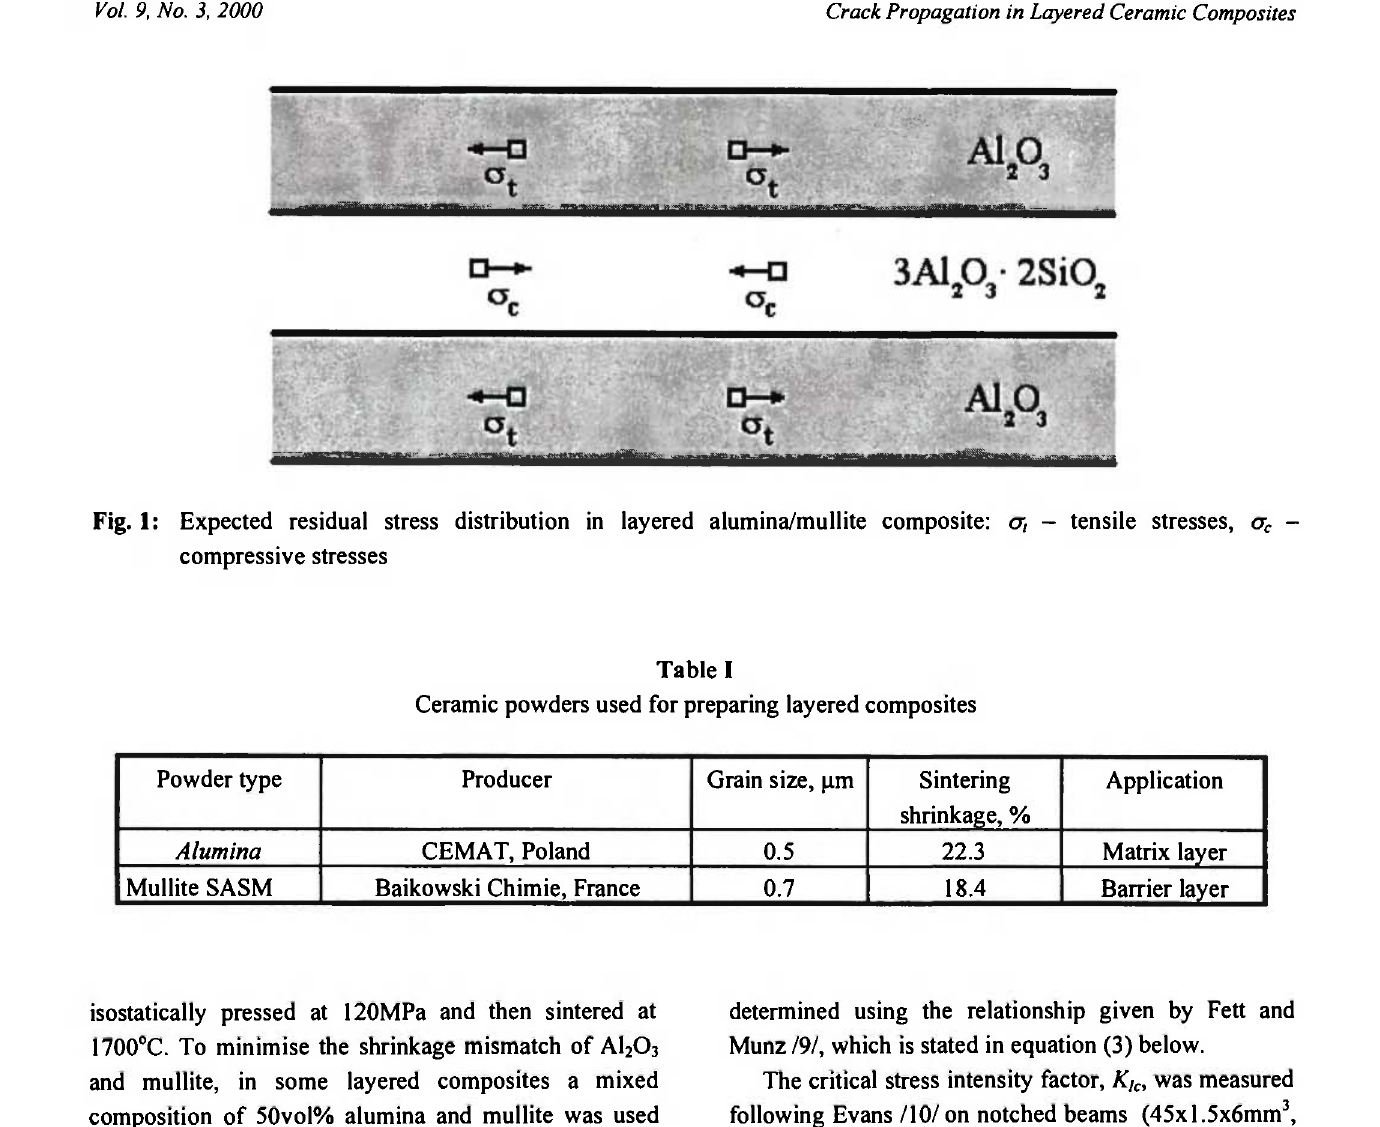
Ceramic powders used for preparing layered composites Powder type Producer Grain size, μηι Sintering Application shrinkage, % 0.5 22.3 Matrix layer 0.7 18.4 Barrier